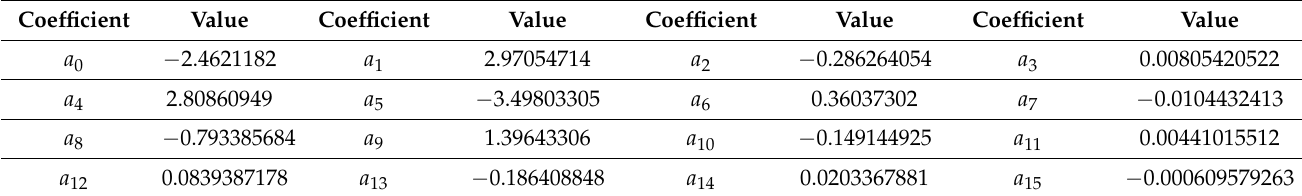
Table 1. The value of constant parameter expression in gas viscosity